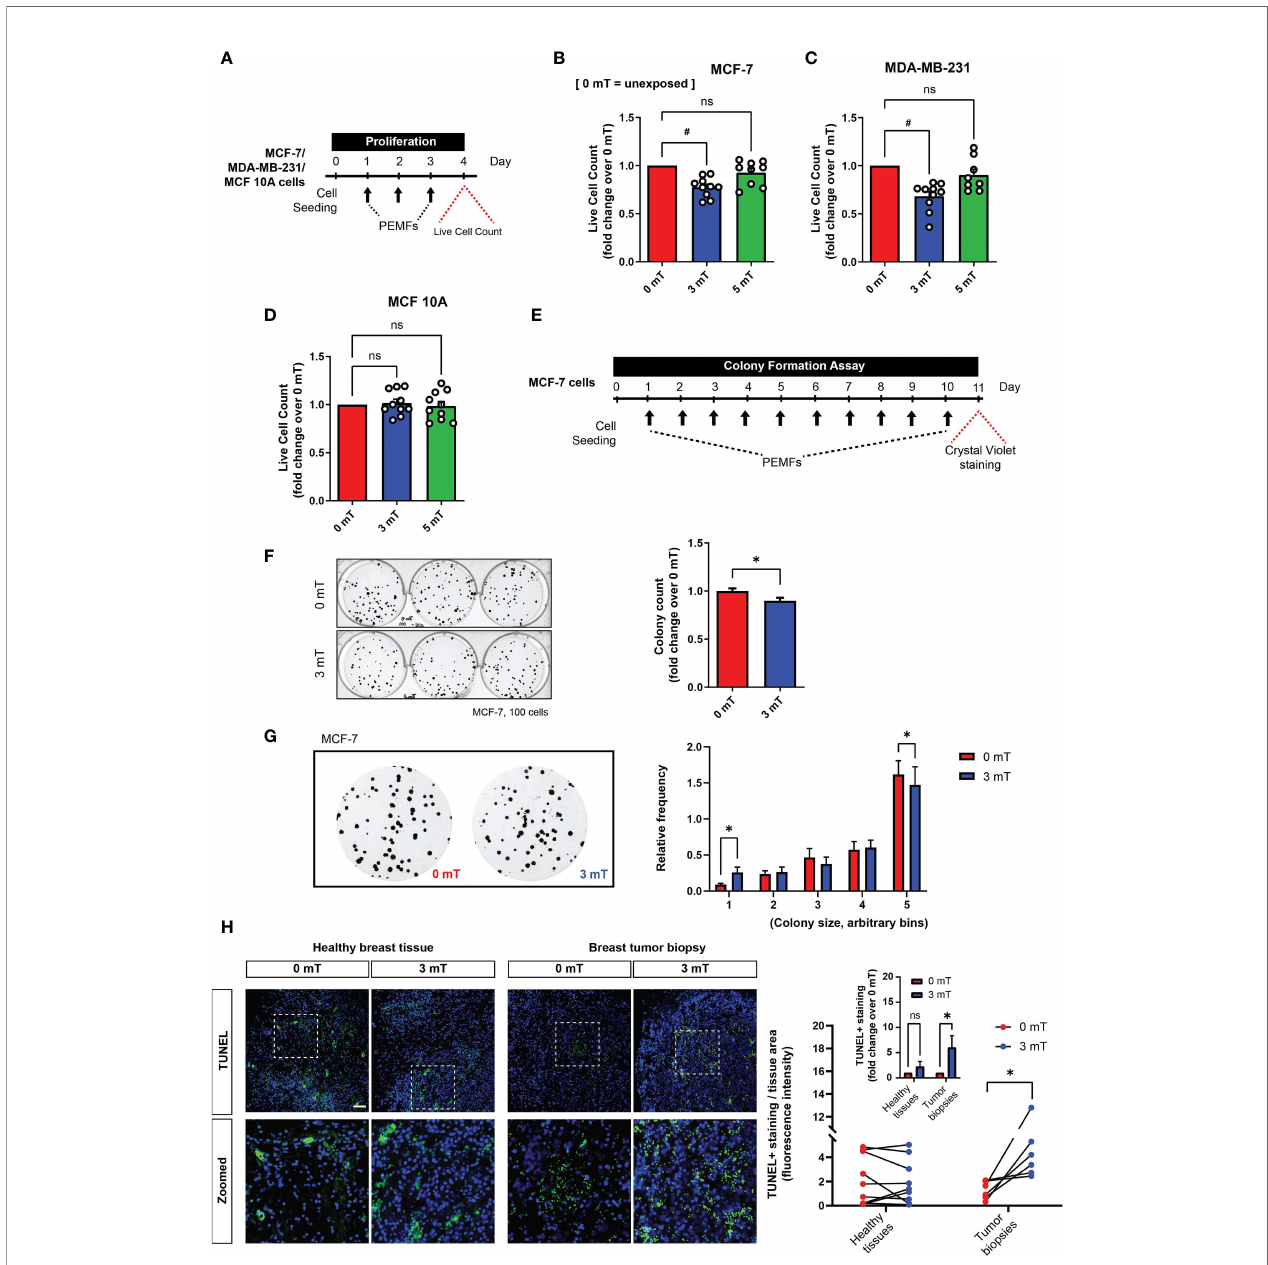
FIGURE 3 | PEMF exposure inhibits cancer cell growth in vitro and ex vivo (human). (A) Schematic of PEMF exposure schedule for live cell quanti fi cation. Live cell counts using Trypan Blue exclusion assay for MCF-7 (B) , MDA-MB-231 (C) and MCF10A (D) cells. Cells were exposed to 0 mT, 3 mT, or 5 mT PEMF for 1 h each day for 3 consecutive days before cell quanti fi cation with # p < 0.0001. (E) Schematic of MCF-7 clonal colony formation regime. PEMF exposure was conducted at 3 mT for 1 h/day. Representative images of MCF-7 cell colonies formed with and without PEMF exposure (left) and associated quanti fi cation of surviving colonies shown as fold change over 0 mT (right). (G) Blown-up images of MCF-7 colonies formed with (3 mT) and without (0 mT) PEMF exposure (left) and corresponding colony size frequency distributions normalized to the total number of colonies (right). Cells were seeded at a density of 100 per well. Data generated from 3 to 6 independent biological replicates with * p < 0.05. The error bars represent the standard error of the mean. ( H , left) TUNEL staining (green) of paired breast tumor biopsies or healthy breast tissues 24 h following 3 mT PEMF exposure or in the unexposed (0 mT) state. Nuclei were stained with DAPI (blue). Scale bar = 100 µm. ( H , right) Corresponding line plot showing changes in TUNEL staining between paired samples exposed to 0 mT or 3 mT PEMFs per tissue area. Each line represents one independent patient sample divided into two parts for independent treatment and compared using one-tail paired t -test. Inset graph is the pooled average of the same TUNEL analysis after the normalization of 3 mT/0 mT of every individual sample, expressed as fold change over 0 mT. Analysis was performed using Two-Way ANOVA with Sidak ’ s multiple comparisons test, with * p < 0.05 and the error bars represent the standard error of the mean. ‘ ns ’ indicates statistically nonsigni fi cant